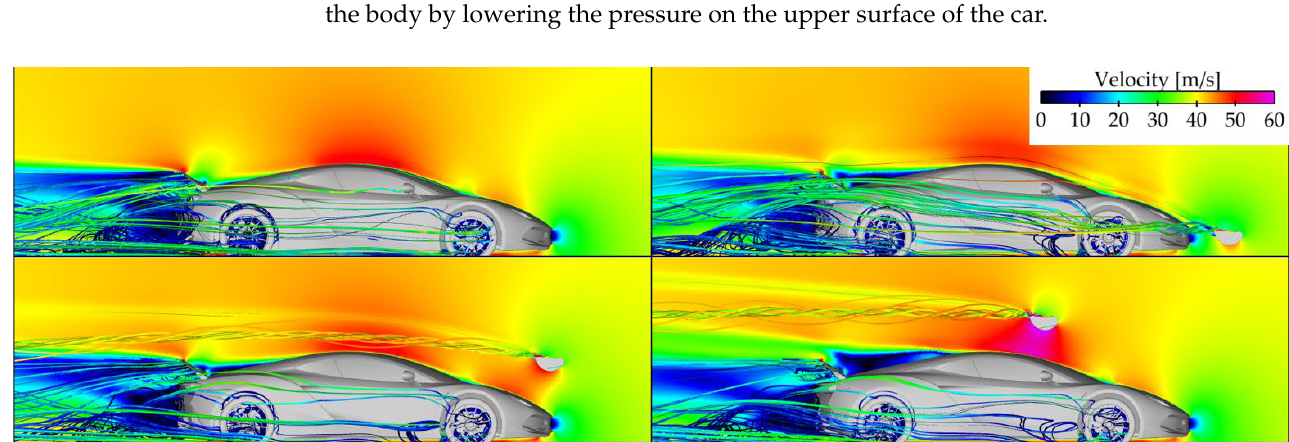
Figure 29. Positions of wings, as visualized in the next figures.